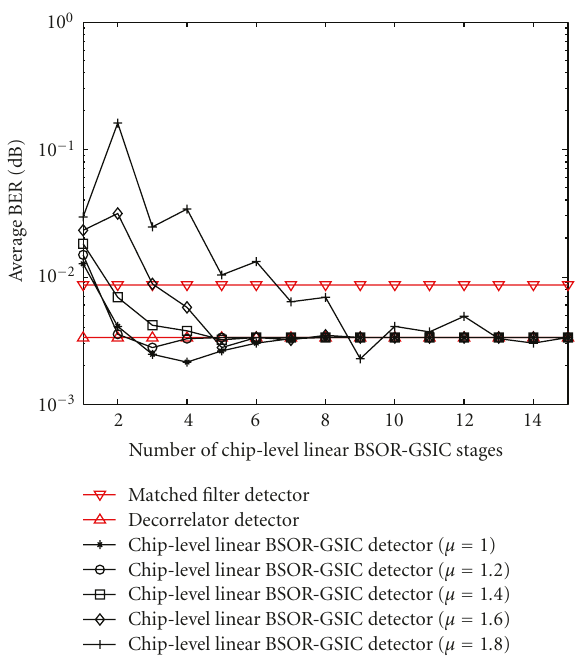
Figure 6: Convergence behavior of the chip-level linear BSOR- GSIC detector for di ff erent values of the relaxation factor.